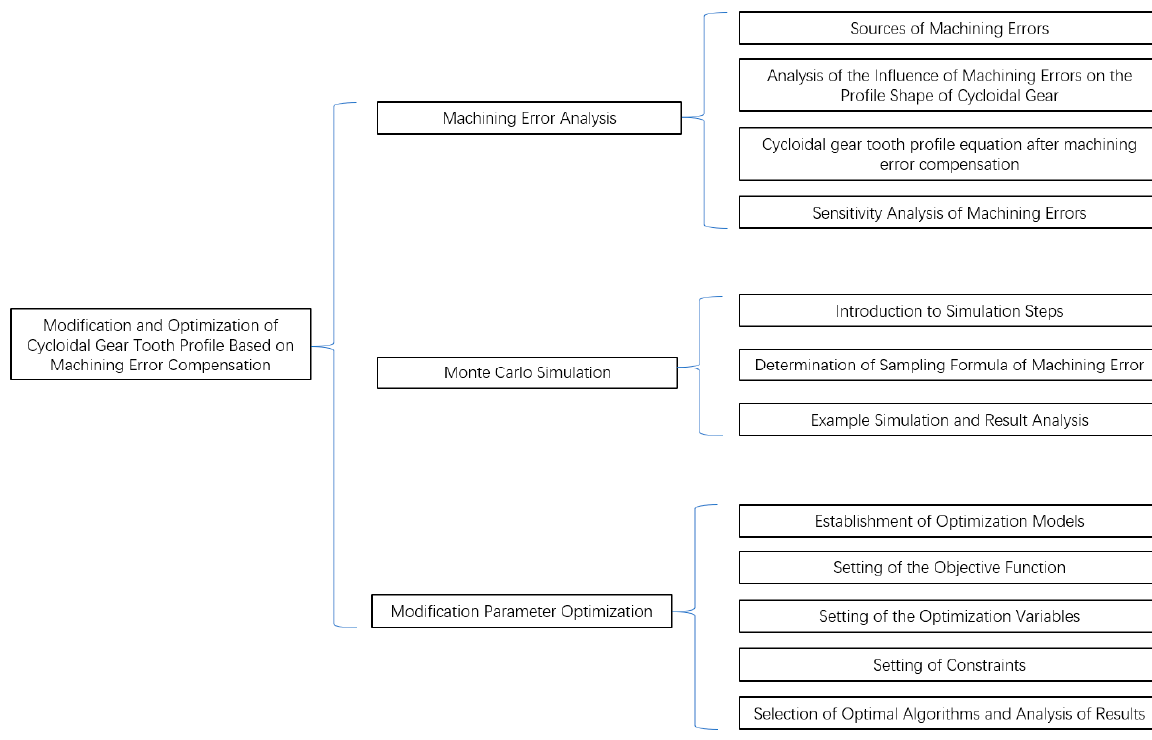
Figure 2. The outline of the structure of the paper.